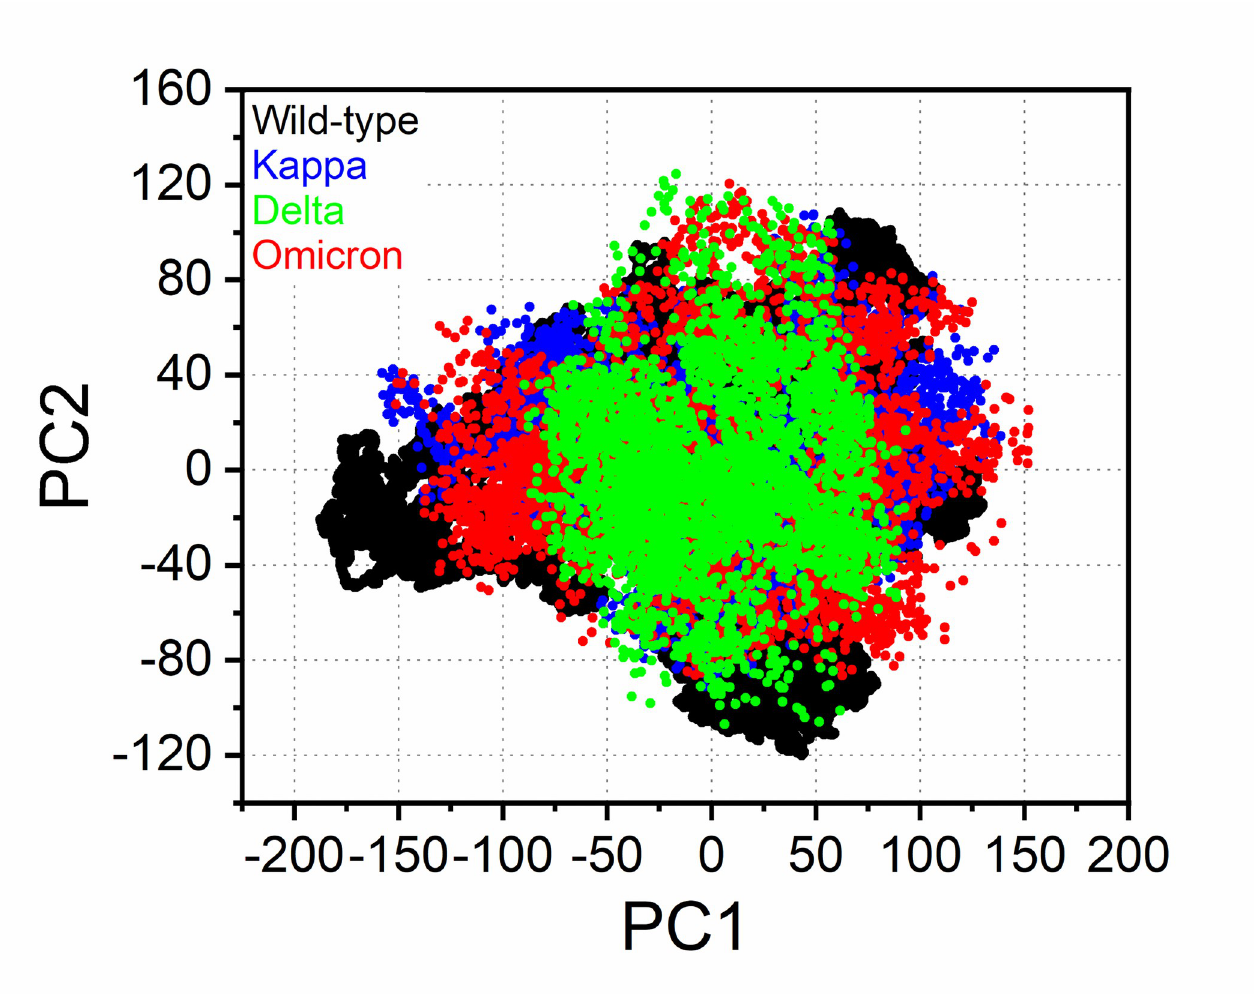
Fig 8. PCA projection of the motion of C α –atoms of the RBD-bound S-RBD complex. The PCA profiles were obtained by plotting the first two principal components (PC1 and PC2) in the various conformation of the Kappa (blue), Delta (green), Omicron (red) and the wild-type (black) systems. PC1 and PC2, respectively, represent a covariance matrix after elimination of eigenvectors. Each point between the single-directional motions represents a unique conformation during the simulation, therefore, similar structural conformations overlap in the graph.